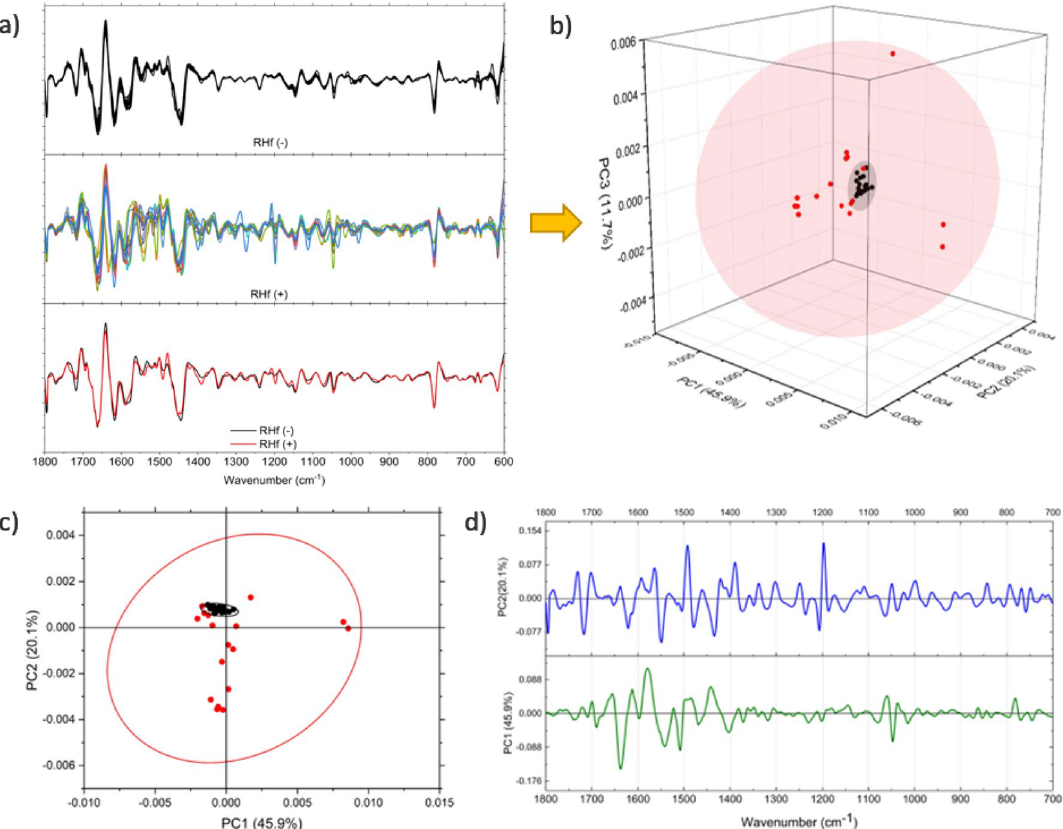
Figure 3. The second derivative of spectra ( a ) were used for PCA scores plot for the 1800–700/cm low- frequency region. The average of second derivative profiles for each group is given in the bottom panel. 3D scatter plot ( b ) and bipolat (score ( c )-loading ( d )) display the clustering of the control group samples on the negative PC2 axis. Positive peaks in the PC2 loading plot show the spectral positions that contributed to the displayed